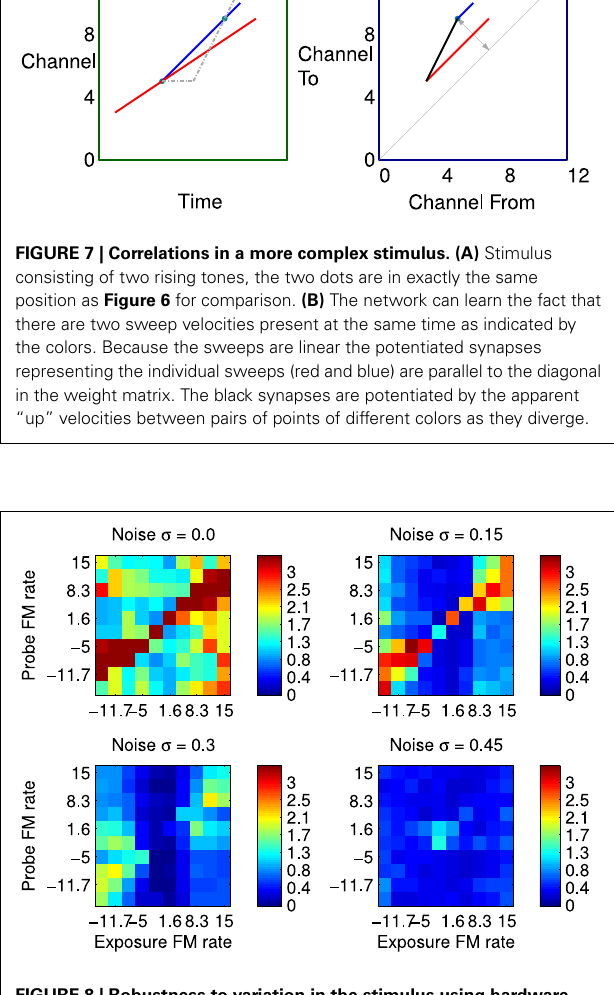
FIGURE 8 | Robustness to variation in the stimulus using hardware implementation and synthetic FM sweeps. These plots illustrate the Stimulus Specific Information for trained network and FM sweeps using noisy stimuli. Subfigures represent increasing values of added noise σ that causes the spike pattern to added to and disrupted from the simple sweep produced by current injection in to successive channels as illustrated in Figure 2 . Color scale is in bits. The maximum value is log 2 ( 10 ) ≈ 3 . 32 as there are 10 classes of stimuli, interpreting each FM rate as a separate class.